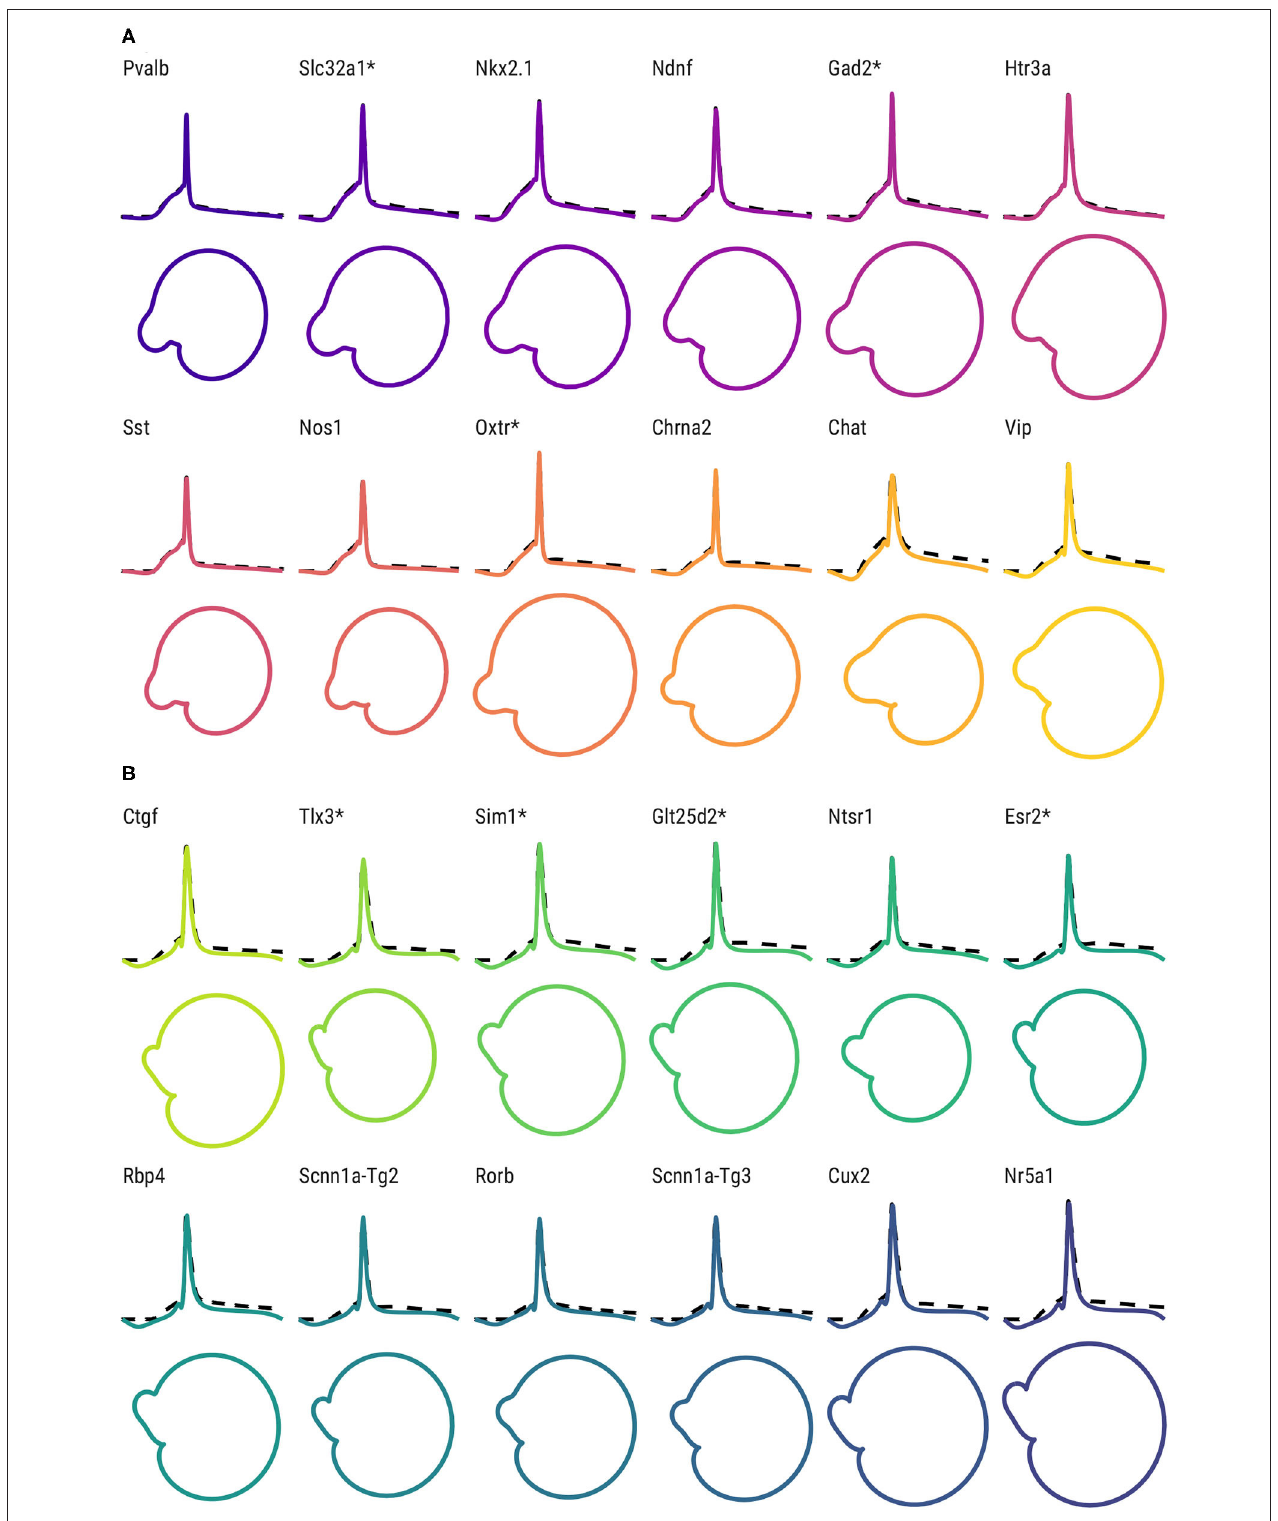
FIGURE 4 | AP shape and phase space for the representative neurons of each Cre line. (Top) FMM predictions (solid lines) and observed AP signals (dashed lines) of representative neurons of GABAergic Cre lines (A) and glutamatergic Cre lines (B) . Bottom: corresponding trajectories in the phase space. Cre lines without available transcriptomic features are marked with